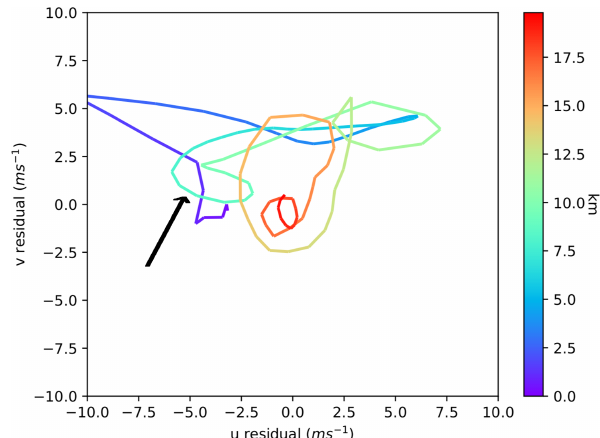
Figure 2. Hodograph in the centre of the jet upwind of Greenland at 60 ◦ N and − 30 ◦ E. The arrow points to the anticlockwise rota- tion between 7 and 10km, with the rest being clockwise or no rota- tion. The hodograph is valid for 9 March at 07:00UTC, calculated from ERA5, and is a good representative for all hodographs upwind, within the jet and through